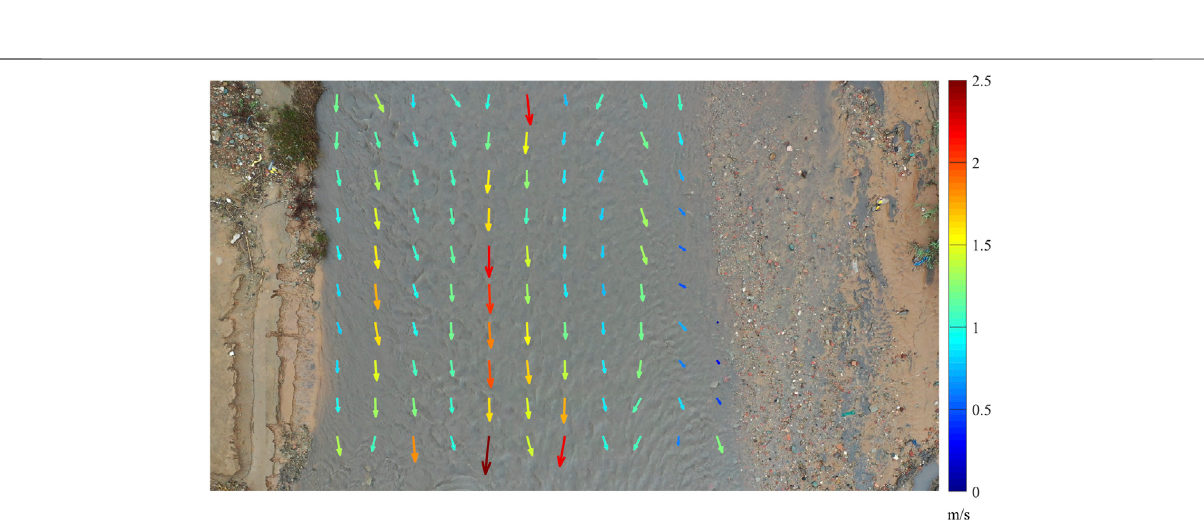
Frontiers in Earth Science |